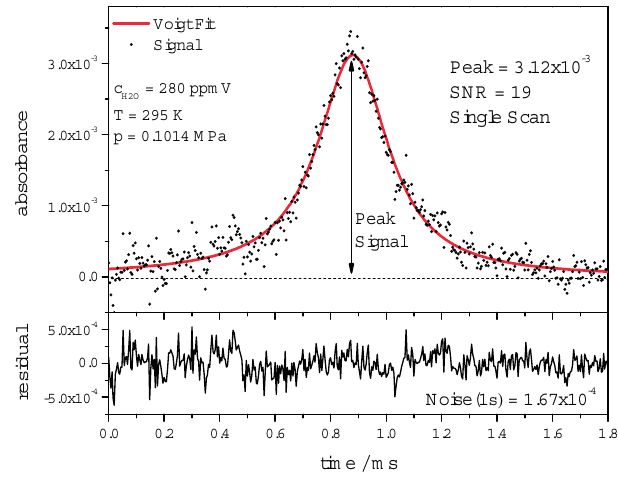
Figure 11. Typical single dTDLAS scan and fit (red) acquired at 280 ppmV H 2 O in air. The fit residuum is shown below with an absorbance noise of 1.67 × 10 − 4 .